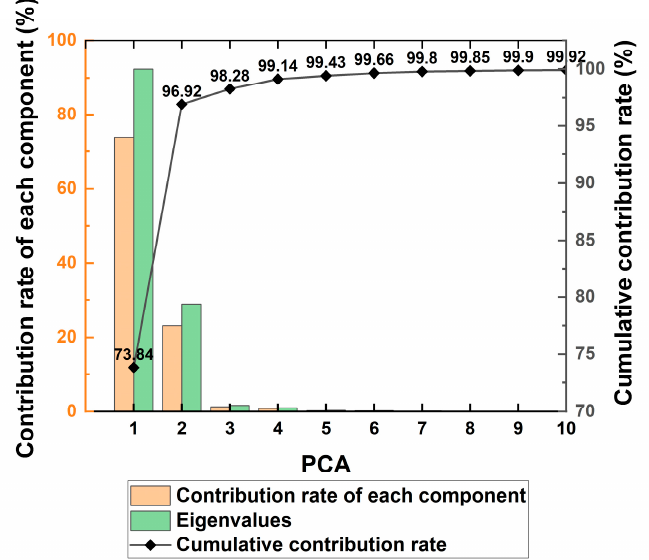
Figure 4. Characteristic values, contribution rate, and the cumulative contribution rate of the top ten principal components.